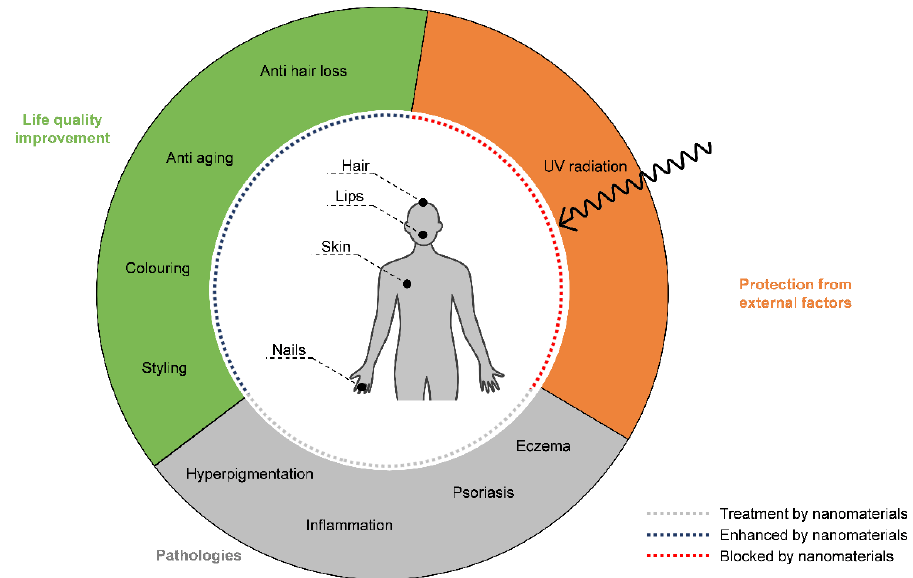
Figure 1. Applications of nanomaterials in the formulation of cosmetics and other products for topical application and their interaction with everyday human activities. Nanomaterials used in hair and skin care products promote quality of life by offering innovations in a range of applications and enhance sunscreen protection. Nanomaterials are also used as delivery system for a range of active pharmaceutical ingredients to treat several skin pathologies.